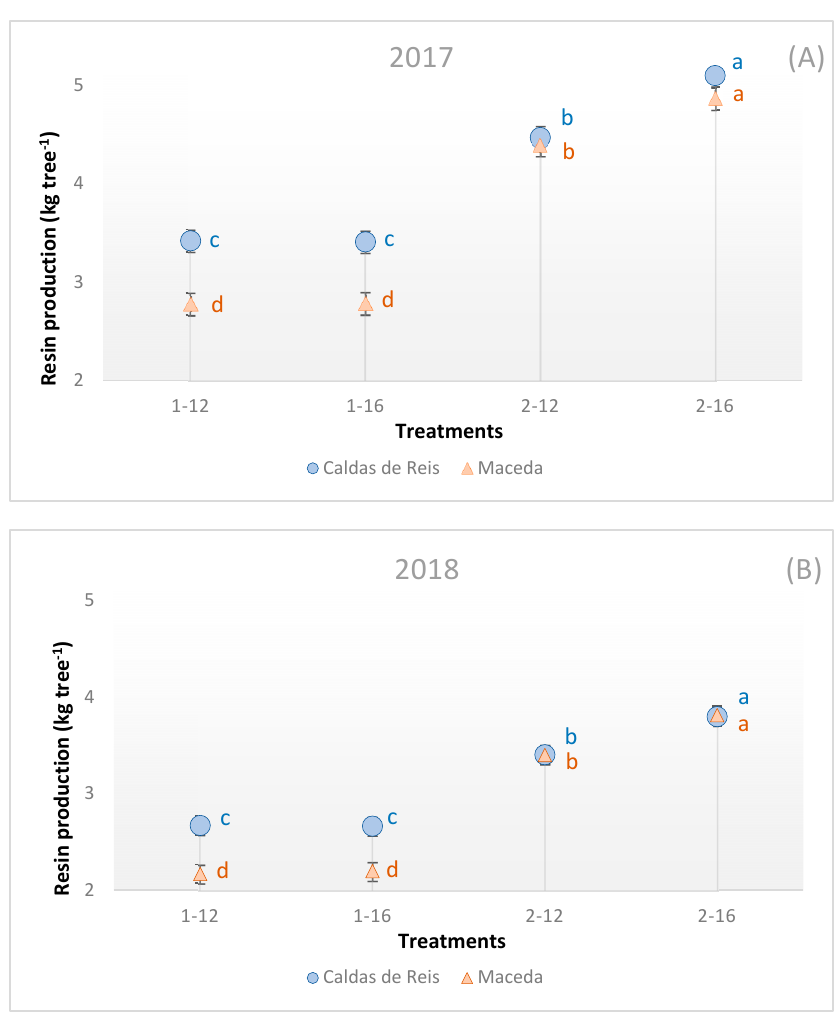
Figure 3. Resin production (kg tree − 1 ) in maritime pine in 2017 ( A ) and 2018 ( B ) in both Caldas de Reis (Pontevedra) and Maceda (Ourense). For each year, different lowercase letters indicate significant differences (LSM, p < 0.05) between the combinations of treatments and locations.